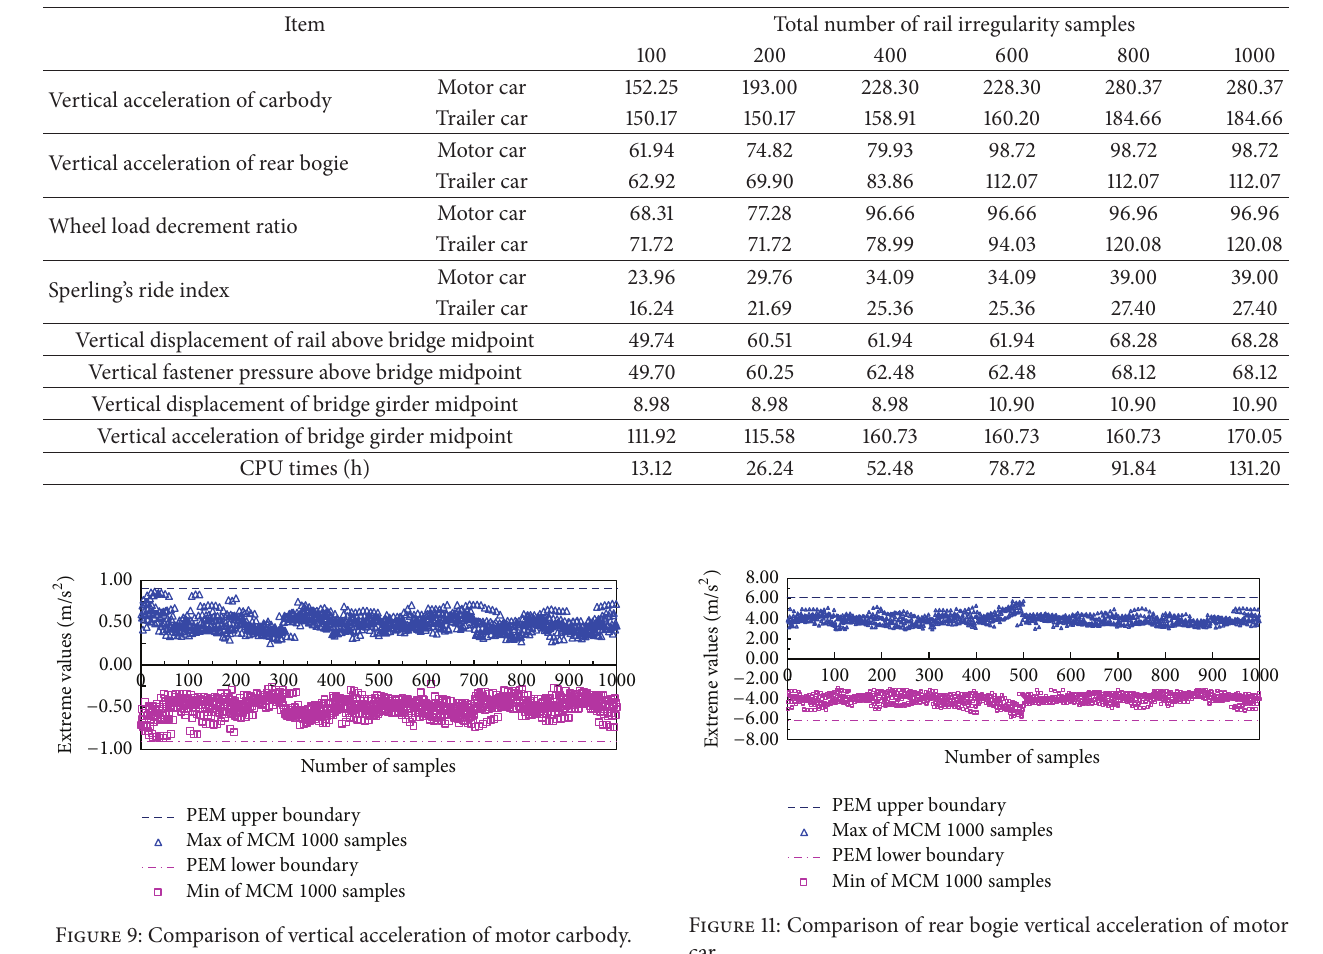
of the responses (%) and CPU times. 2